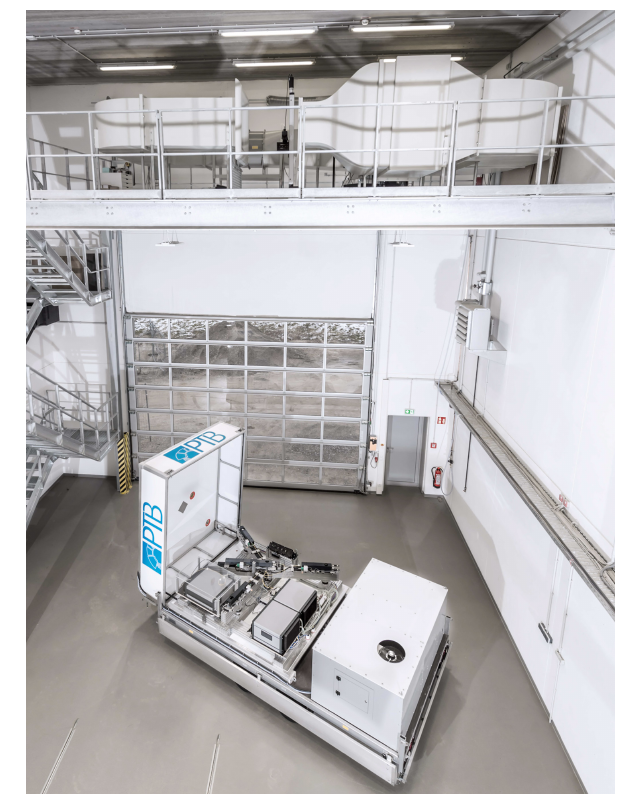
Figure 9. Wind tunnel test facility at PTB with bistatic PTB lidar (opened trailer housing) positioned below the wind tunnel test sec- tion.